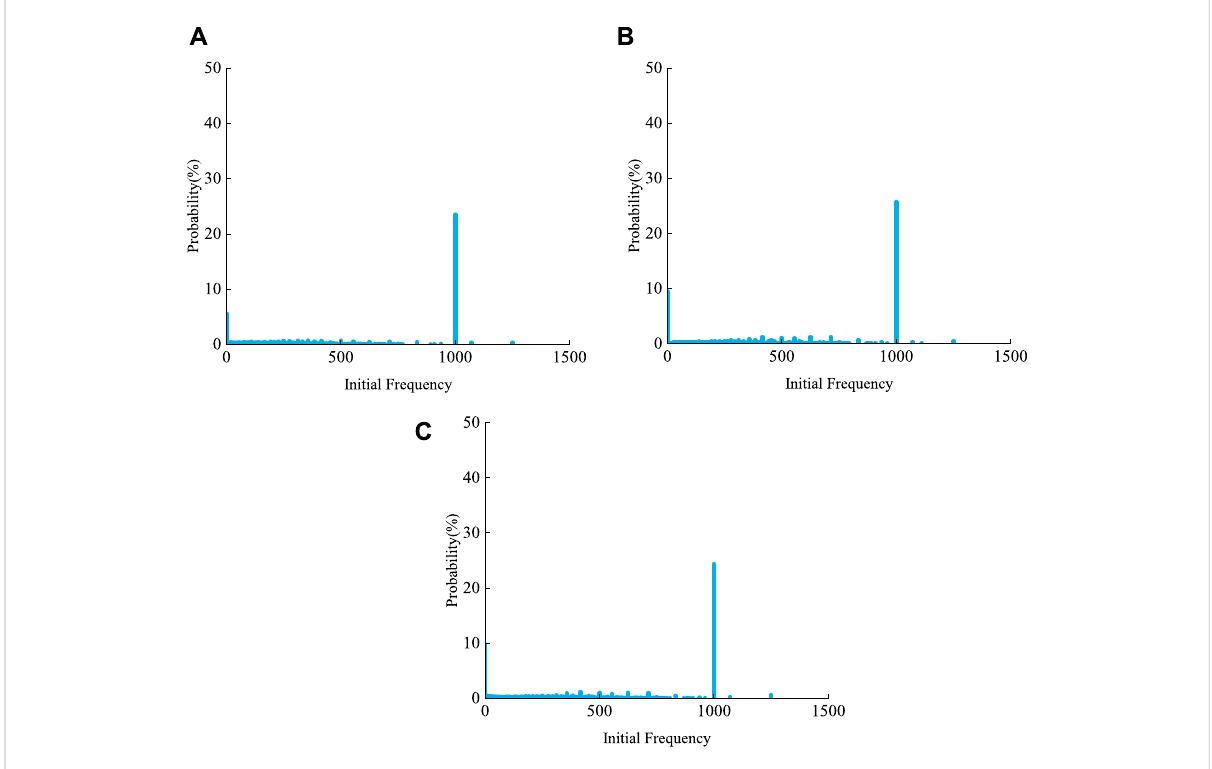
FIGURE 4 Initialfrequencyprobabilitydensitydistributionswerederivedforspecimens (A) G1, (B) G2,and (C) G3(G1,G2,andG3refertothreephosphorite